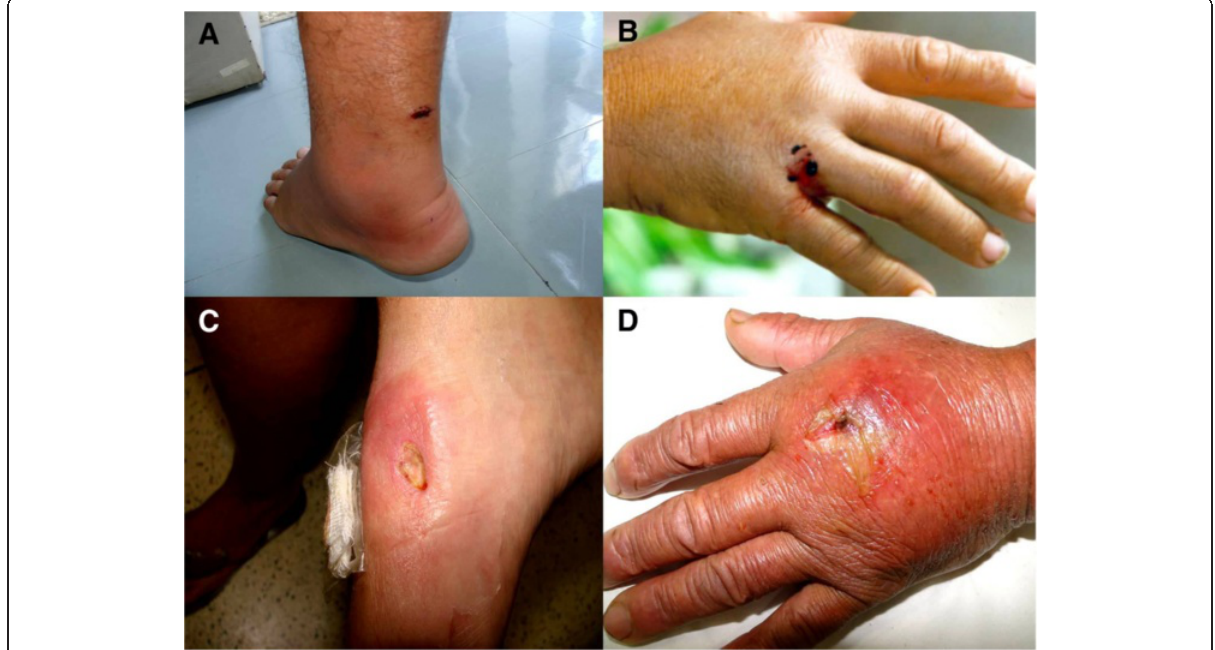
Figure 7 Envenomations caused by marine stingrays. (A) Erythema and edema in a heel injury. (B) Fisherman hand injured by a stingray. (C) Ulcer on the left foot of a fisherman. (D) Hand of a fisherman stung by a ray, the wound was associated with bacterial infection. This kind of injury is common in fishermen of shrimp communities, since the caught stingrays remain at the bottom of the boat. Photo by: Vidal Haddad Junior.